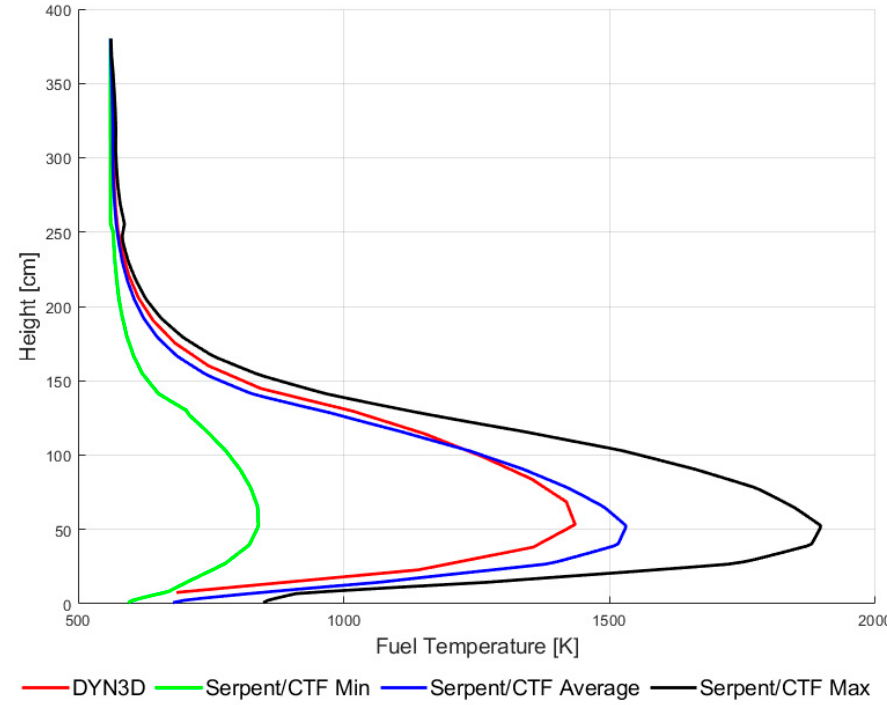
Figure 18. Maximum centreline temperature (K) of the fuel pins in DYN3D and CTF.